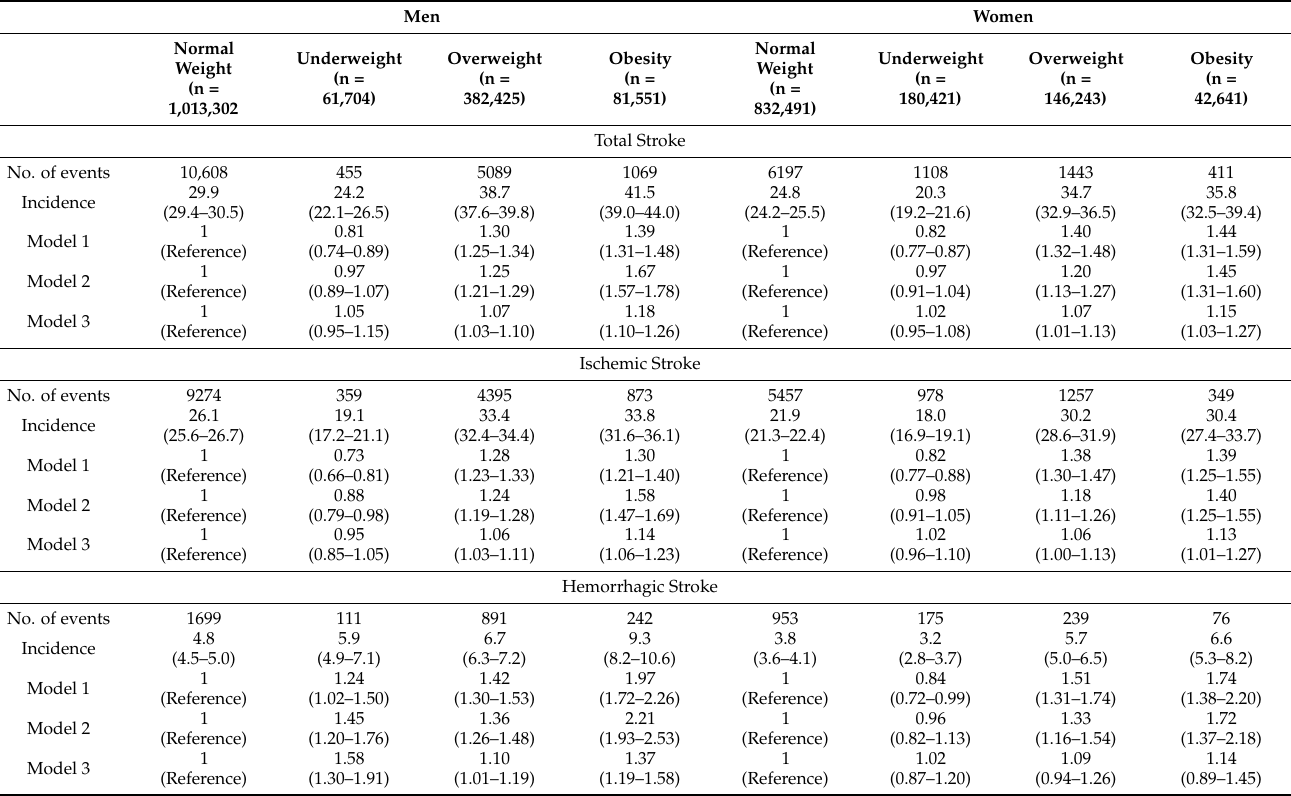
Table 2. Association between Body Mass Index Category and Stroke Events Stratified by